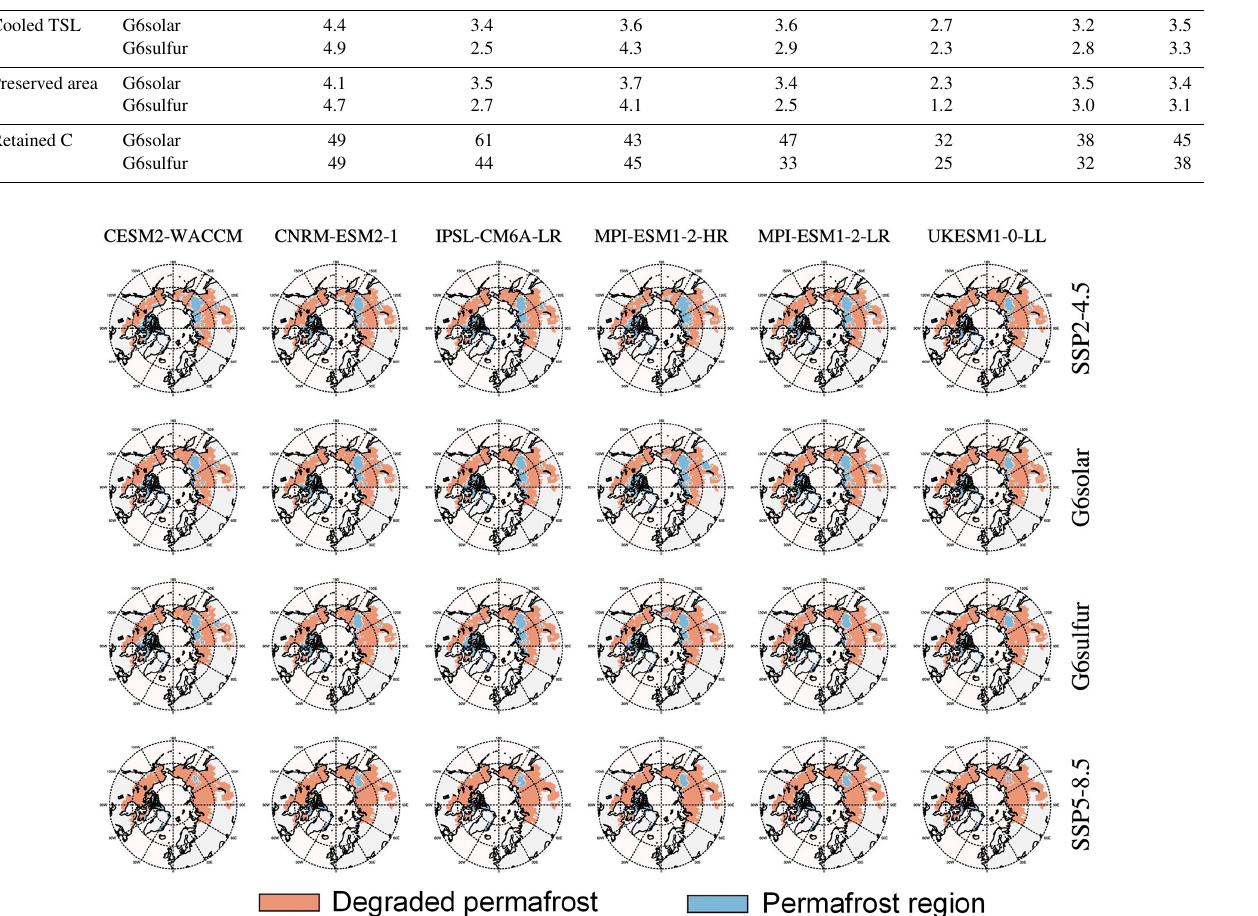
Figure 5. Maps of permafrost extent in the year 2100, derived from the bias-corrected TSL outputs of six ESMs. Permafrost regions with active layer depths greater than 3m in 2100 are considered degraded